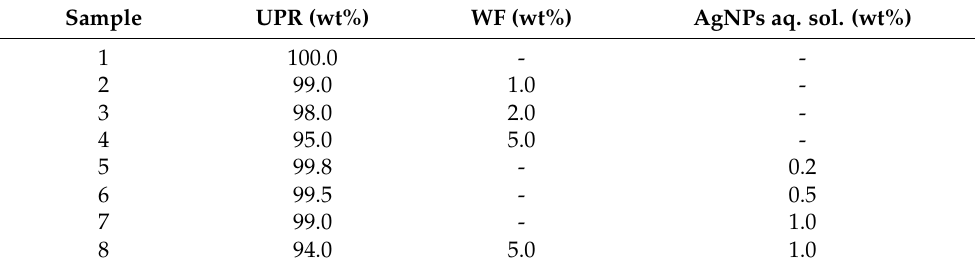
Table 1. The compositions of the prepared composites.